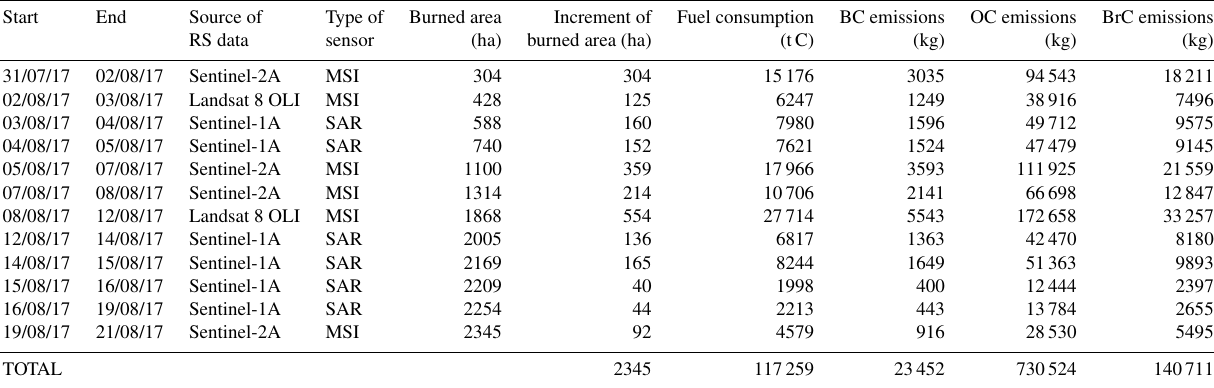
Table 1. Start and end date of releases, source of data, type of sensor, burned area and daily increment of burned area, fuel consumption and calculated BC emissions from Eq. (1) during the Greenland fires in